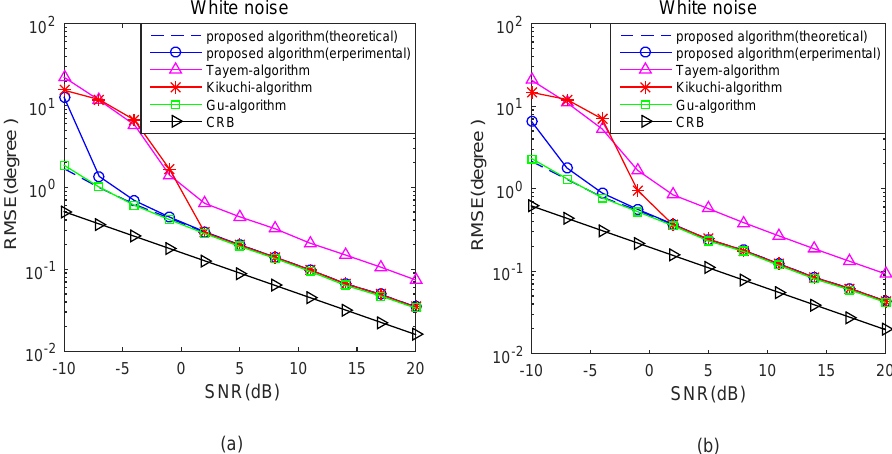
Figure 5. RMSE versus SNRs in a white noise situation. ( a ) s 1 ( t ) ; and ( b ) s 2 ( t ) .